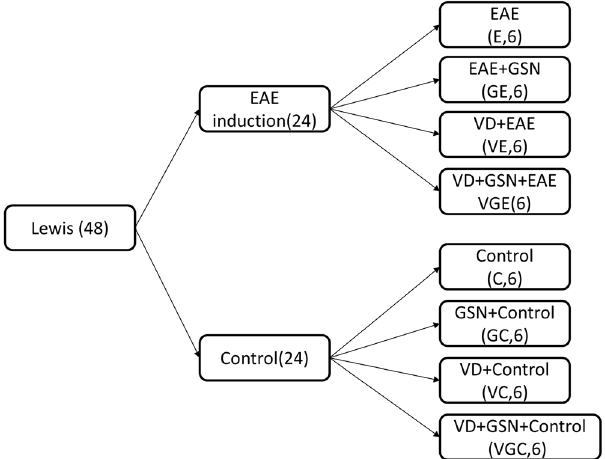
Figure 1. 48 Lewis male rats were first divided into 2 groups based on EAE induction (EAE) or not (control). Then each group was divided into 4 groups. The first group was treated with vitamin D 3 (VC and VD), the second group was injected with LV-GSN (GC and GE), the third group was both treated with vitamin D 3 and injected with LV-GSN (VGC and VGE), and the last group was without treatment (C and